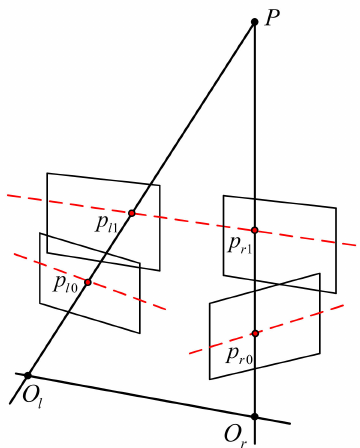
Figure 2. Stereo image